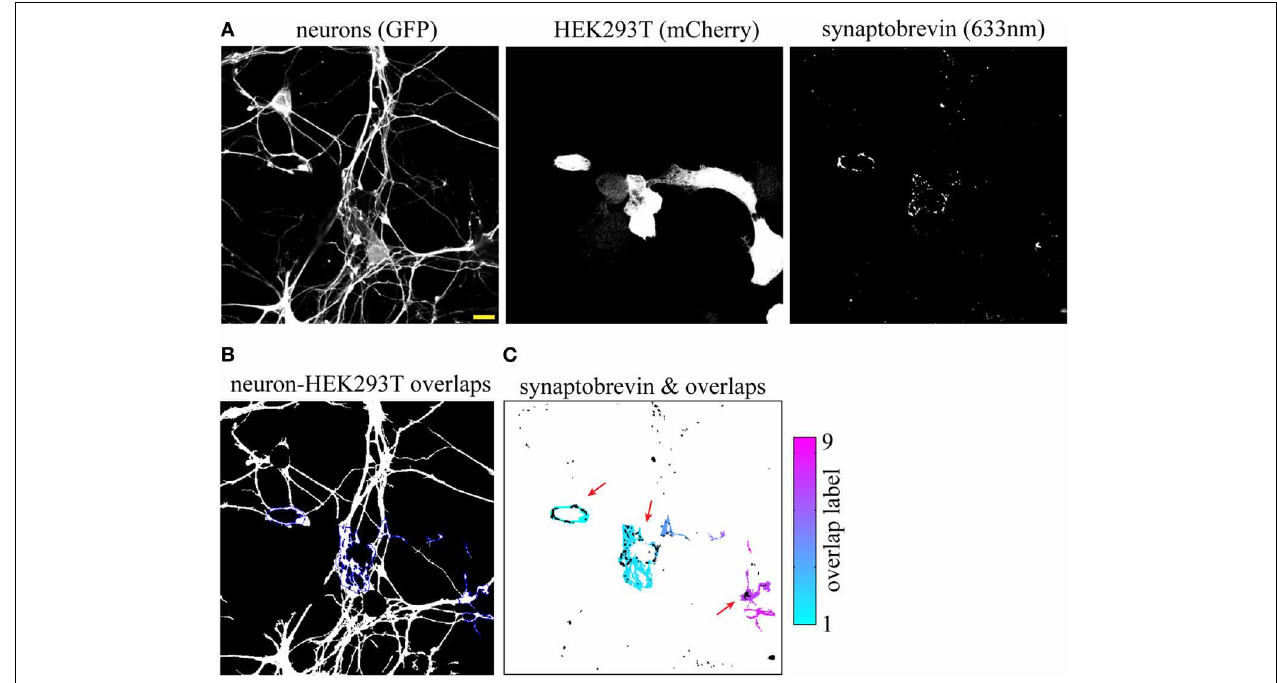
FIGURE 2 | Synaptic vesicle (SV) cluster detection using high (63 × ) magnification images. (A) Input images. The field shown corresponds to the one magnified in Figures 1J–L . (B) Neuron-HEK293T overlap regions